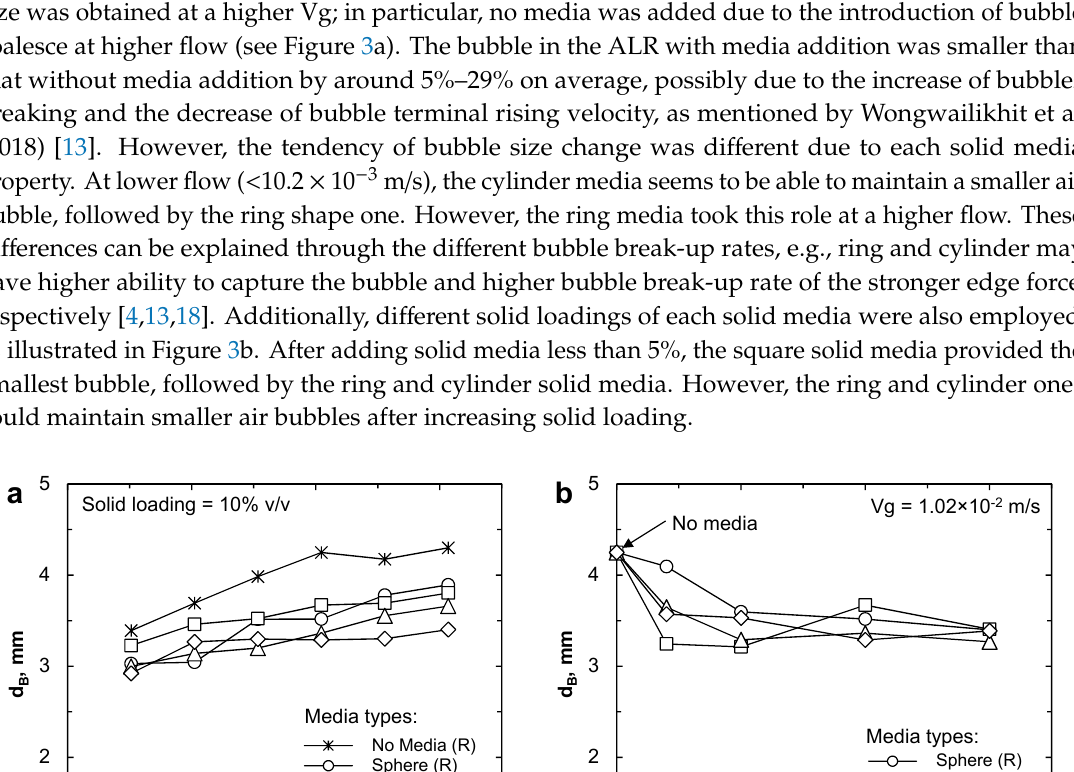
Figure 4. Bubble rising velocity (U B ) in BCR of each solid media type with: (a) superficial gas velocity (Vg) and (b) solid loading.